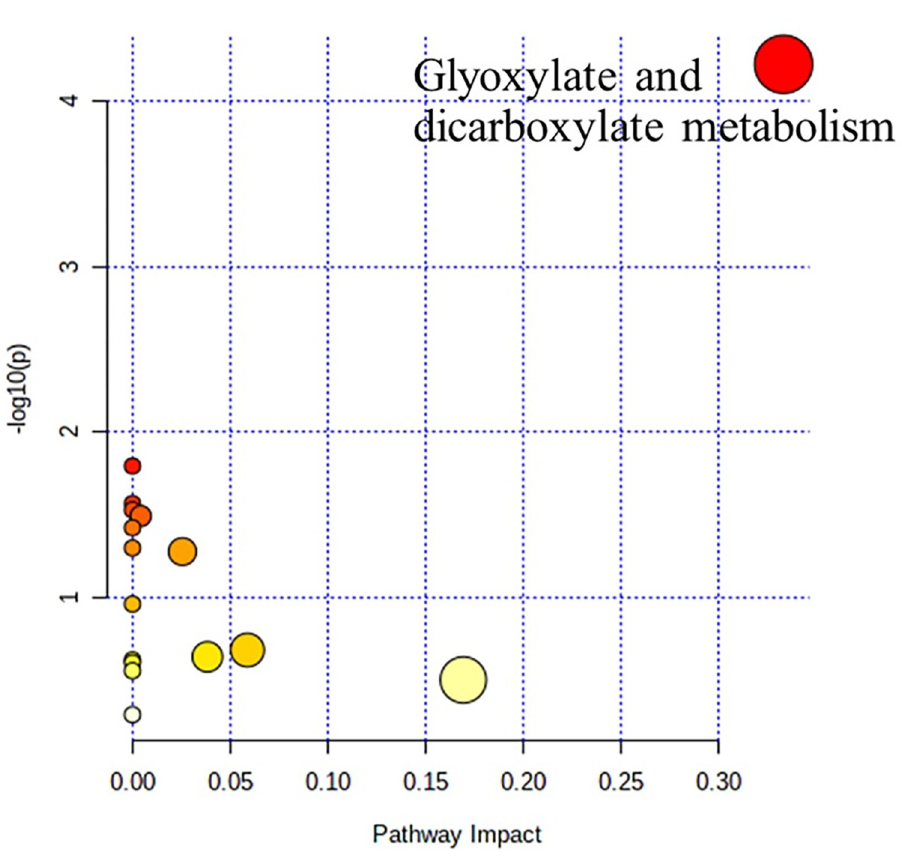
Fig 6. Graphical overview for the metabolome viewing of the pathway analysis. The X-axis indicates the impacts on pathway, while the Y-axis indicates the significance of changes (-log ( p )) in the pathway by the identified metabolites represented by different color